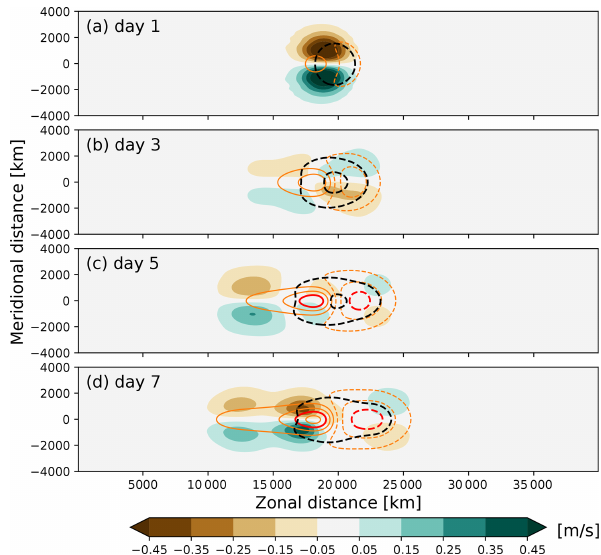
Figure 11. Developing wave response in response to an equatorial SST anomaly on a β plane for full PE. From top to bottom, the rows show the development after (a) 1d, (b) 3d, (c) 5d, and (d) 7d lead time, respectively. The panel setup is the same as in Fig. 7 but show- ing wind in the lowest of three levels ( σ = 5 / 6) and with the con- tour interval for the surface pressure anomaly decreased to 1hPa. The additional orange and red contours show zonal wind anoma- lies relative to the initialization with a contour interval of 1ms − 1 centred around zero and the ± 2 . 5ms − 1 contour